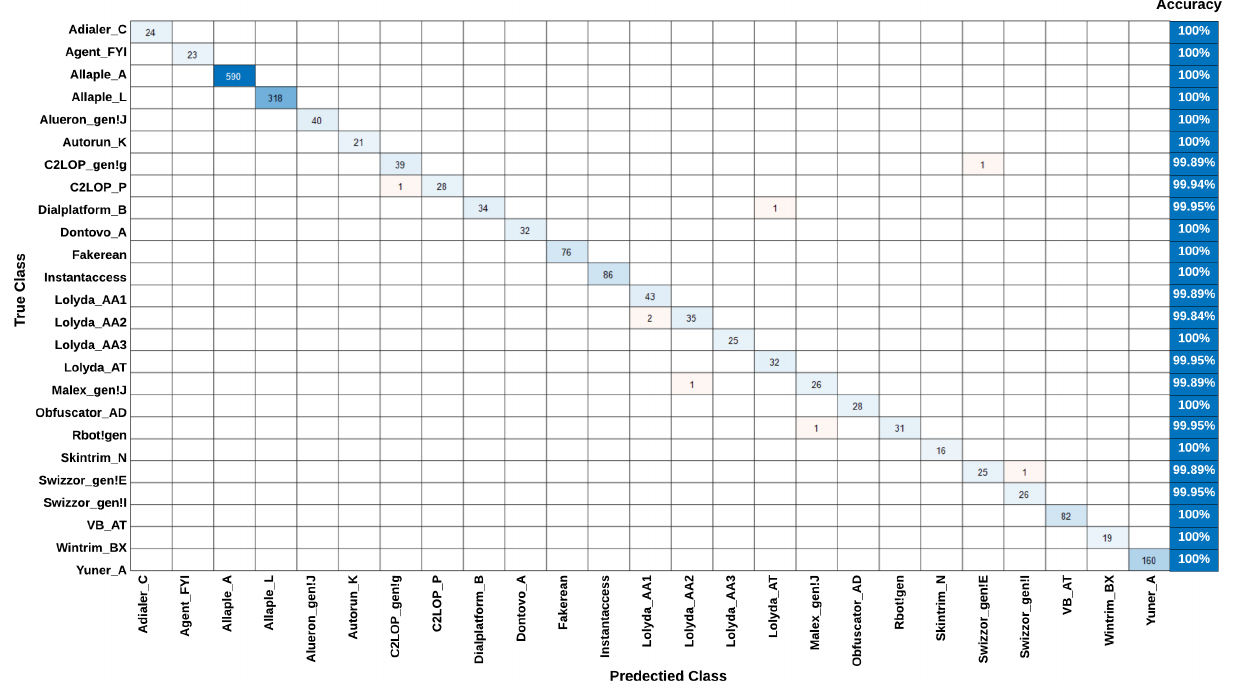
Figure 6. Confusion matrix of the fine-tuned VGG16 classification